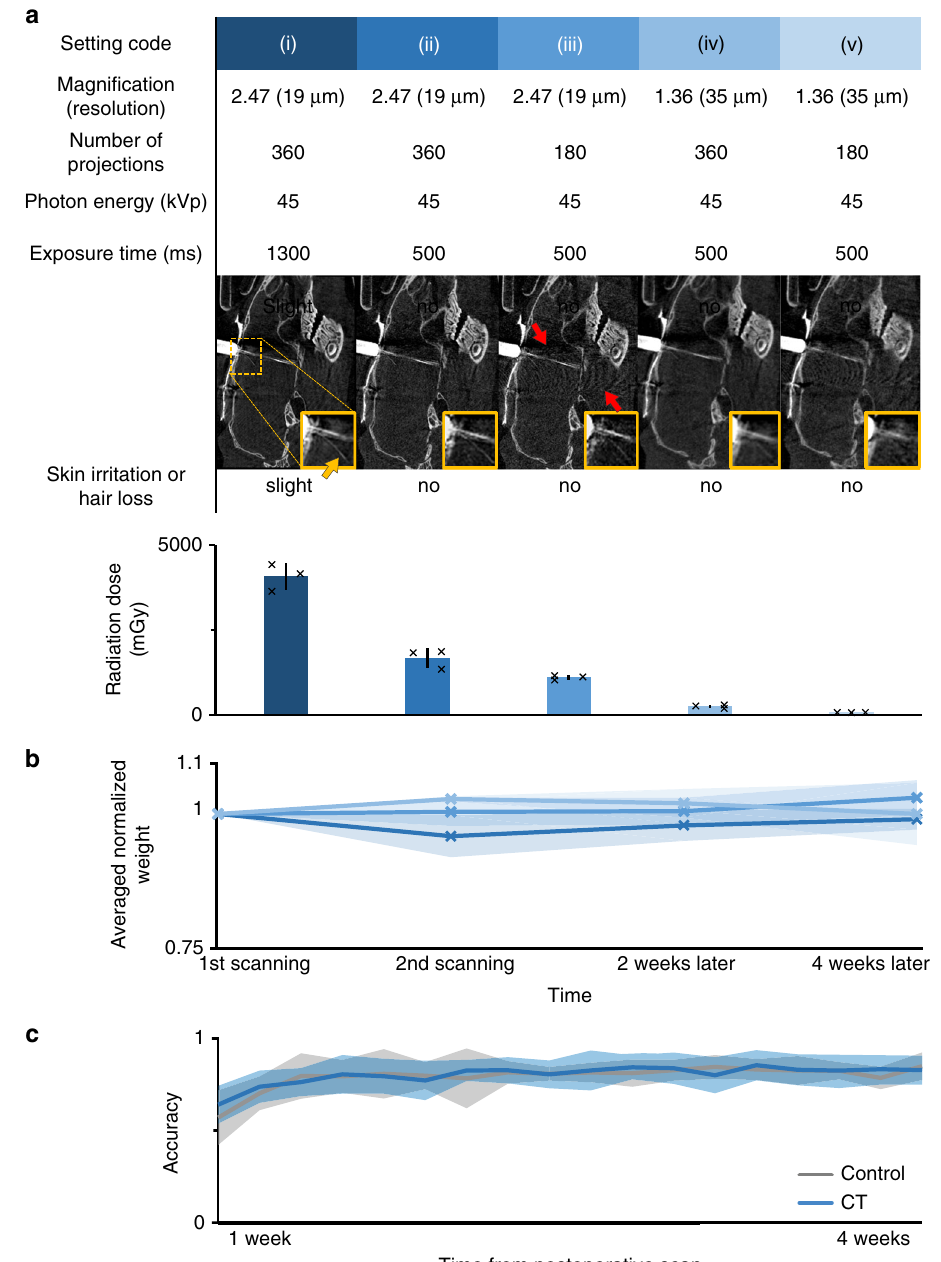
Fig. 10 Optimization of image quality and radiation dose. a Top, acquisition settings for CT; middle, corresponding image of a tetrode drive implant (grayscale images; for silicon probe and optical fi ber implants, see Supplementary Fig. 9); bottom, radiation effects and measured doses ( n = 3 mice in each group; n = 15 mice in total). Error bars show standard deviation from the mean; markers show individual data points. The yellow arrow shows a bent single tetrode in the magni fi ed image, indicating the spatial resolution of the images. Red arrows show artifacts caused by the metal parts of the microdrive, more apparent for lower exposure time and number of projections. b Average normalized body weight of mice ( n = 3 mice in each group, n = 9 mice in total) exposed to two CT scans separated by a 1-week pause, mimicking the protocol used for the localization procedure. The fi rst scan was performed with setting (v), and the settings for the second scan are indicated by the color code adopted from panel a . Error shades show standard deviation from the mean. c Performance of scanned animals ( n = 7 mice, settings (v) and (iii), blue) in a standard fi ve-choice serial reaction time task did not differ